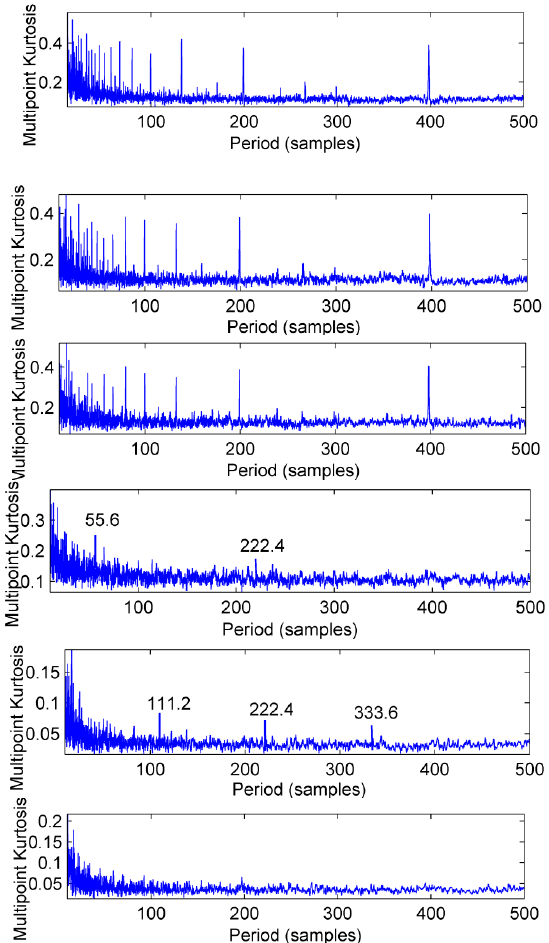
Figure 21. The multi—point kurtosis spectrum of the first six layers after the vibration signal ELMD is decomposed.